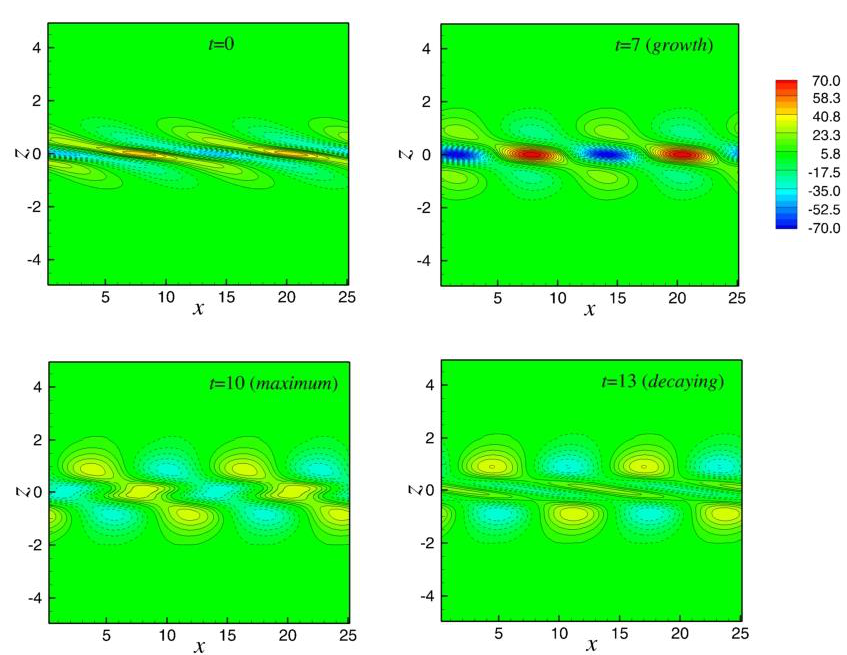
Figure 4. Evolution of the spanwise vorticity component, 𝜂 𝑦 , of a two-dimensional optimal vector calculated for the maximal growth at 𝑡 𝑚𝑎𝑥 = 10. 𝑅𝑖 = 1, 𝑅𝑒 = 1000, 𝛼 = 0.5,𝛽 = 0 . Solid and dashed lines represent positive and negative values of 𝜂 𝑦 .